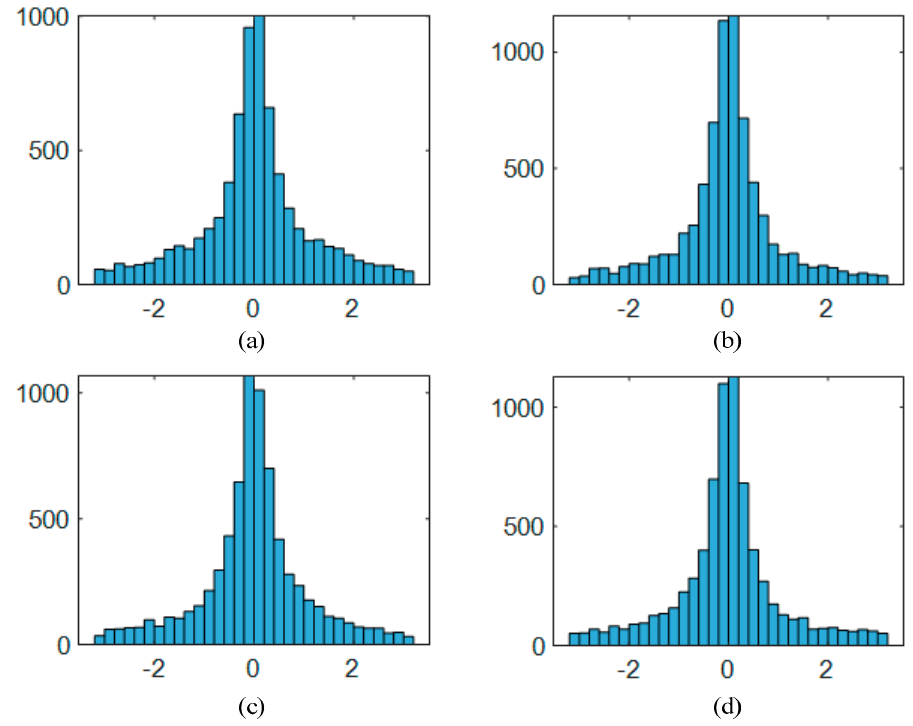
Figure 5. Interferometric image statistics demonstrating the i.i.d assumption within the image and the close variance across the sequence. The ( a ) 1st, ( b ) 5th, ( c ) 20th, and ( d ) 30th interferometric image histograms are shown, wherein the case of Lvshungang observation is taken as an example.